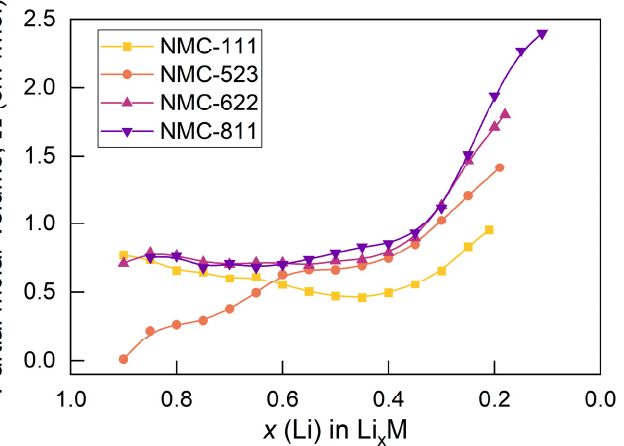
Figure 2. Calculated partial molar volume as the function of normalized lithium concentrations or lithium contents. Table 1. Summary of simulation parameters and material properties for NMC materials used for numerical simulations.